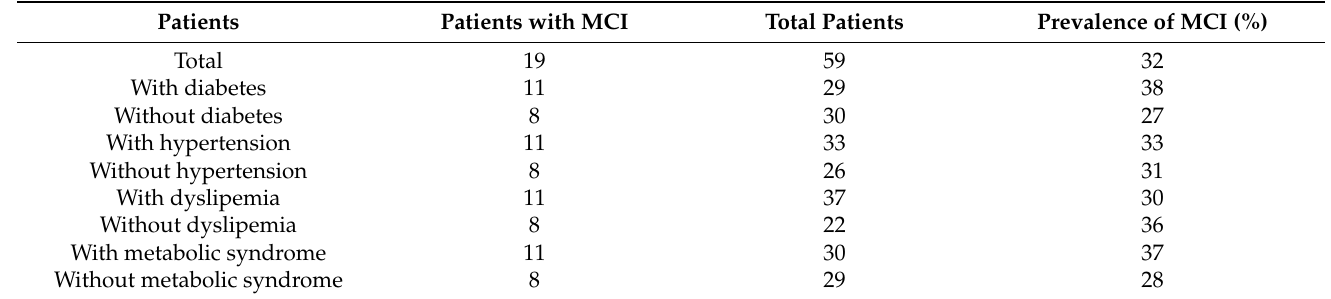
Table 3. Influence of diabetes, hypertension, dyslipemia, and metabolic syndrome on the prevalence of MCI in patients with NAFLD. Patients Patients with MCI Total